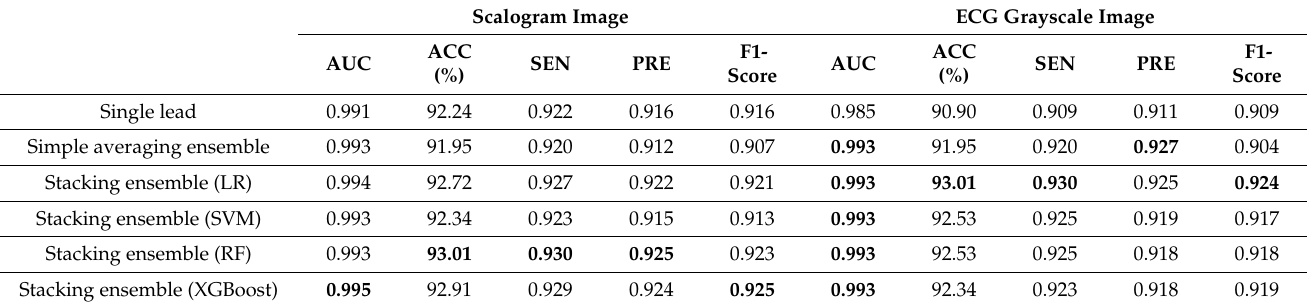
Table 4. Diagnostic performance of two single leads (Lead II lead for scalogram image and aVR lead for ECG grayscale image), single-modal simple averaging ensemble, and single-modal stacking ensemble methods for scalogram and ECG grayscale